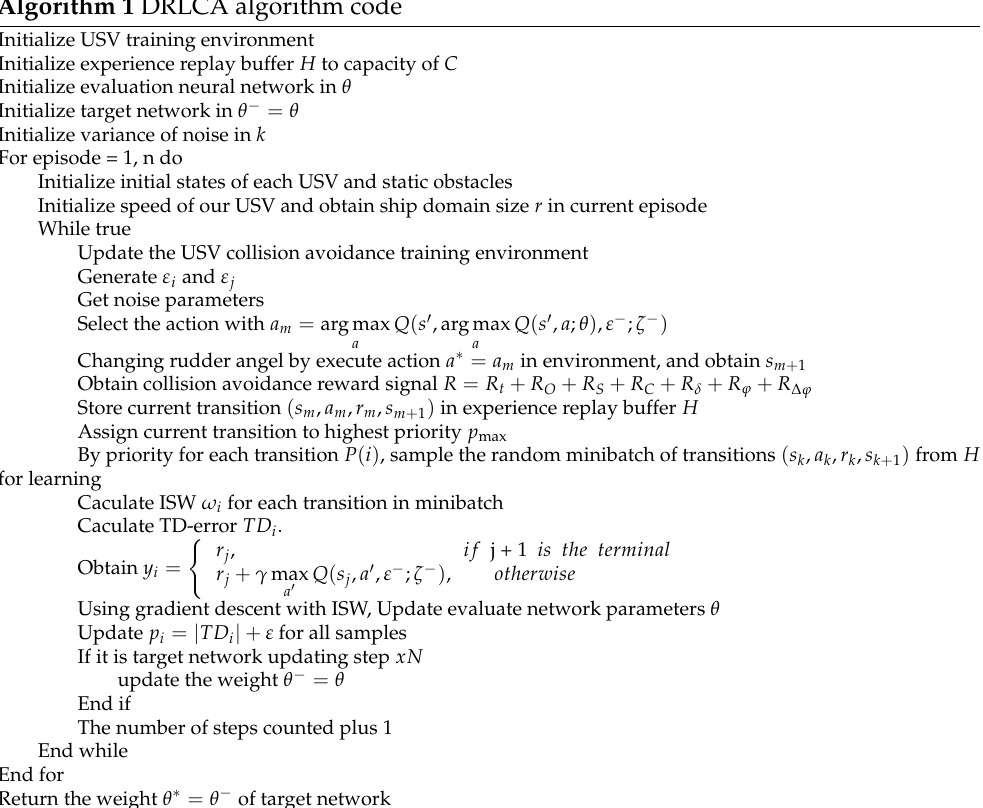
Algorithm 1 DRLCA algorithm